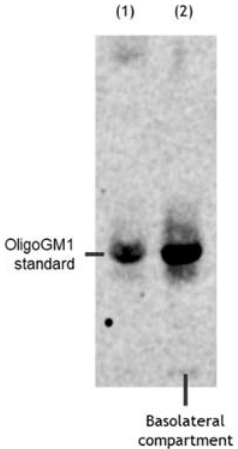
Figure 5. OligoGM1 stability after hBLEC transport. Representative image of the HPTLC separation of the radioactive material contained in the basolateral compartment ( n = 4). Lane 1: standard [ 3 H]OligoGM1; lane 2: concentrated solution from basolateral compartment derived from direct transport experiment with 50 µ M and 1 × 10 6 dpm [ 3 H]OligoGM1 after 240 min. The result is representative of those obtained for all the experiments. HPTLC plate was developed using the chloroform / methanol / 0.2% CaCl 2 solvent system at 30:50:13 by volume. Tritium was detected with the Beta ‐ Imager 2000 instrument (Biospace) using an acquisition time of 17 h.